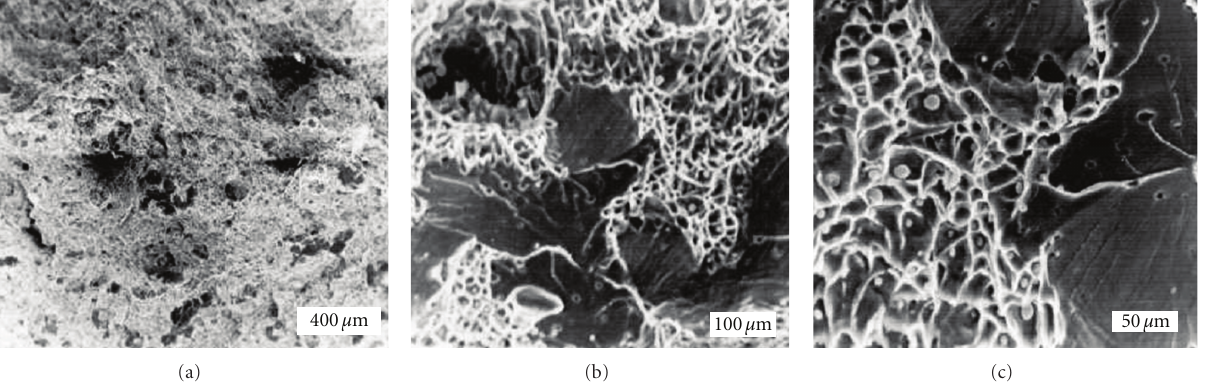
Figure 3: Fractography of the iron grade OSCh 6-2 with 2% porosity specimens: (a) × 75; (b) × 400; (c) × 750.